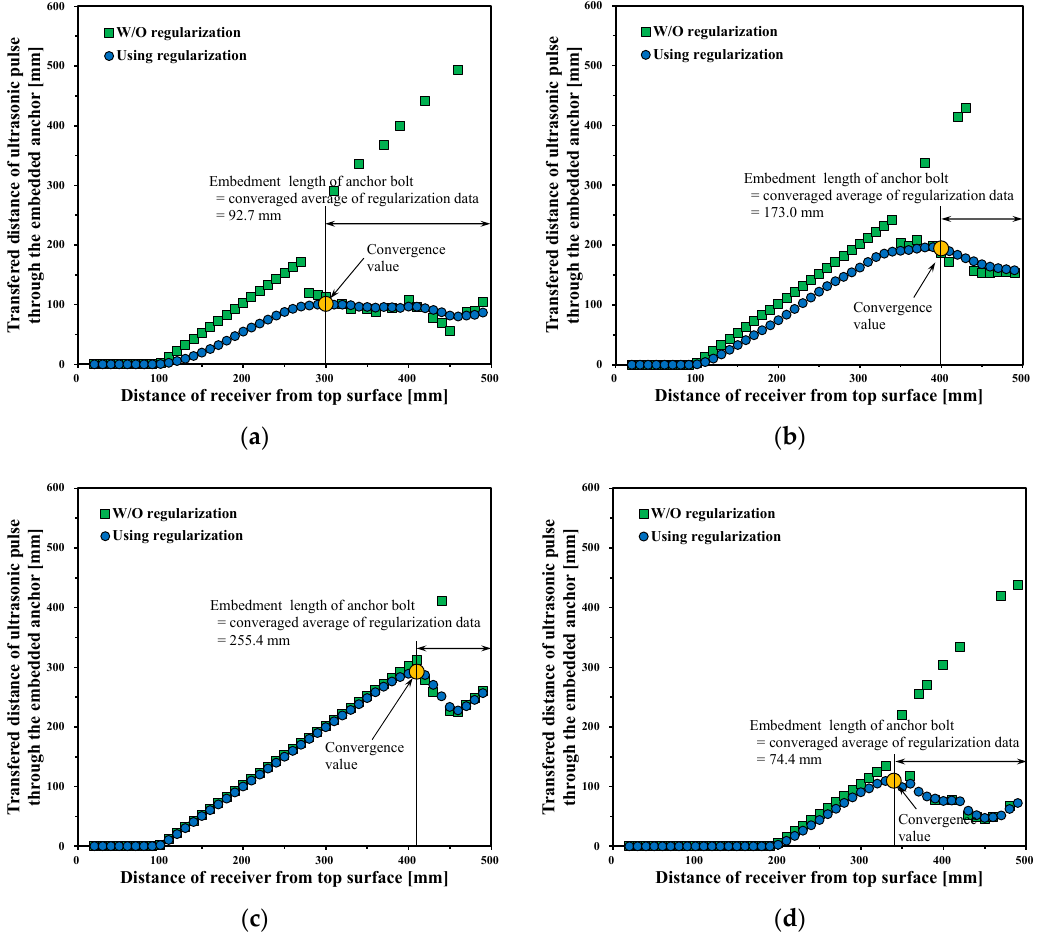
Figure 11. Results of the experimental verification: ( a ) E100C100; ( b ) E200C100; ( c ) E300C100; and ( d ) E100C200.